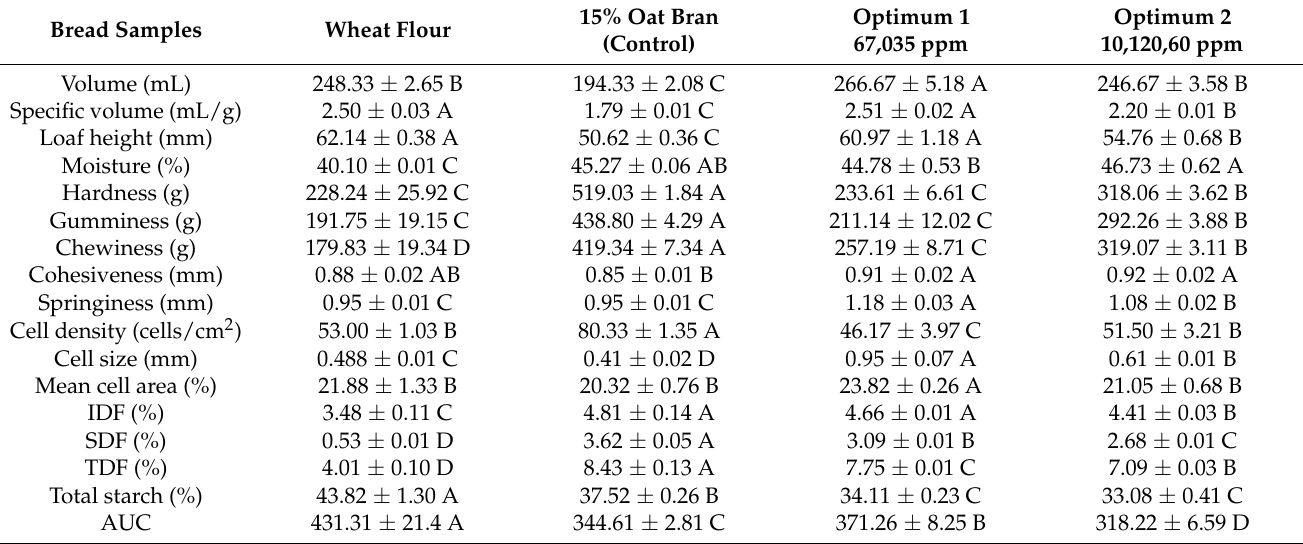
Table 5. Optimal